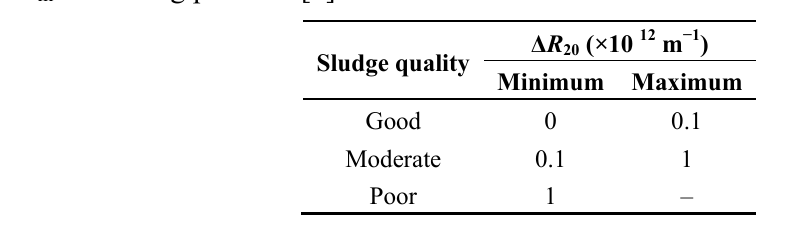
Table 4. Δ R values and corresponding MBR activated sludge filterability-for standard 20 DFC measuring protocol m